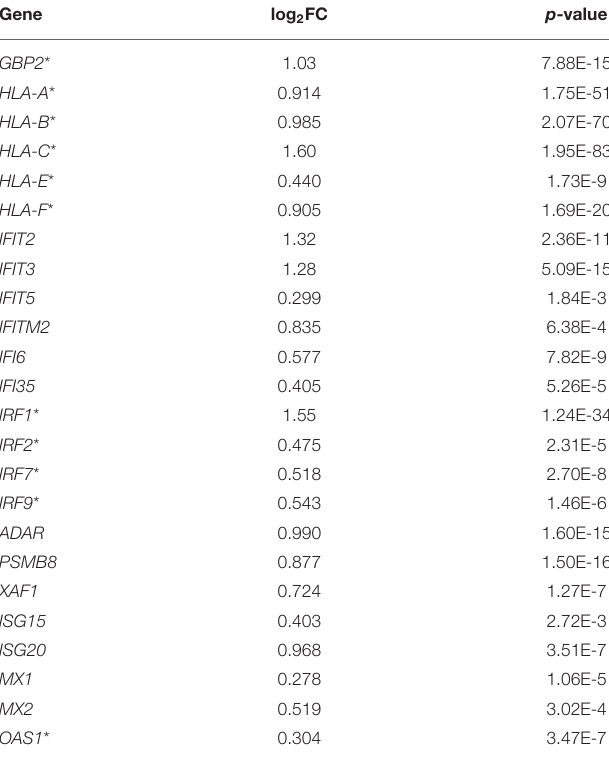
TABLE 3 | Type I IFN-stimulated genes are upregulated in monocytes/macrophages from HS lesions compared to healthy control skin. Gene log 2 FC p